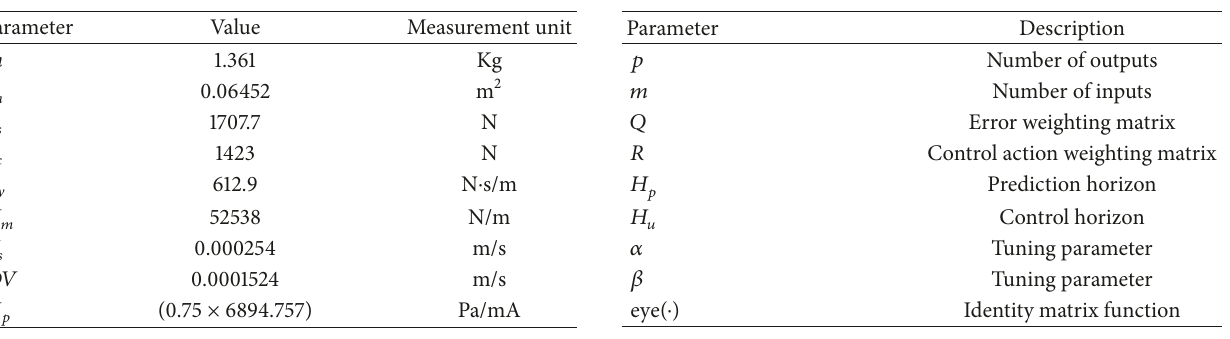
Table 5: Predictive controller parameters.